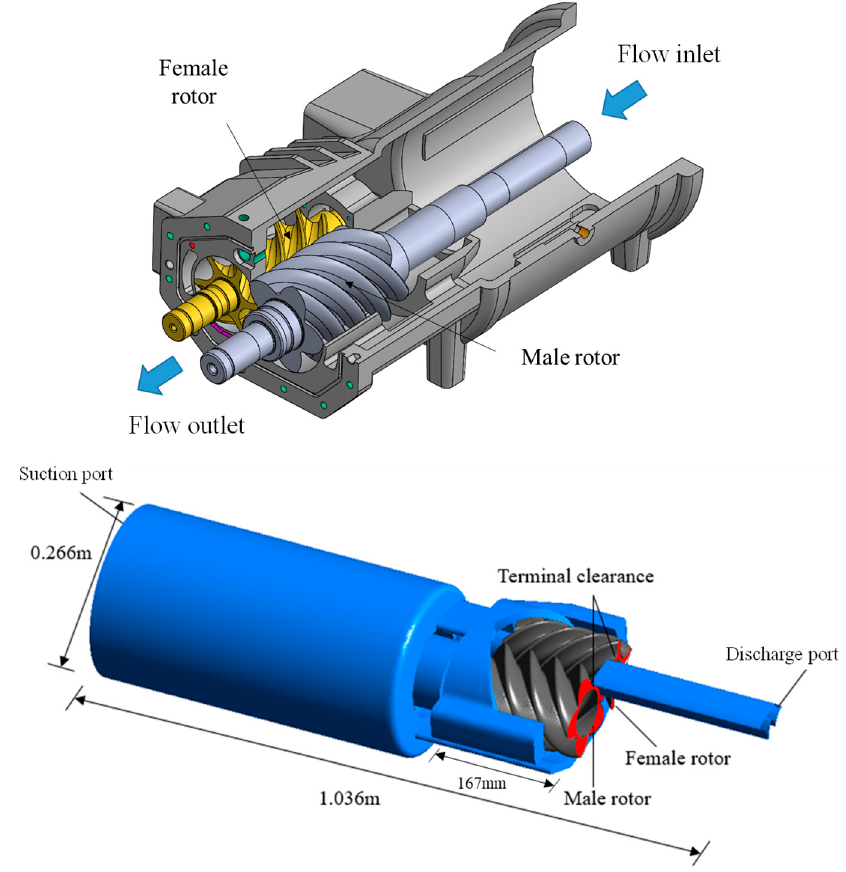
Figure 1. The geometry of the screw compressor and the fluid domain. The lobe combination of the rotor was 5/6 and the rotor profile was provided by Fusheng industries. The male rotor had five lobes, a 138.54 mm outer diameter, and the designated wrap angle was 290 ◦ . The female rotor had six lobes and the outer diameter was 109.86 mm. The geometrical parameters of the screw machine are listed in Table 1. The interlobe and radial clearances between the lobe and casing were 0.06 mm and 0.04